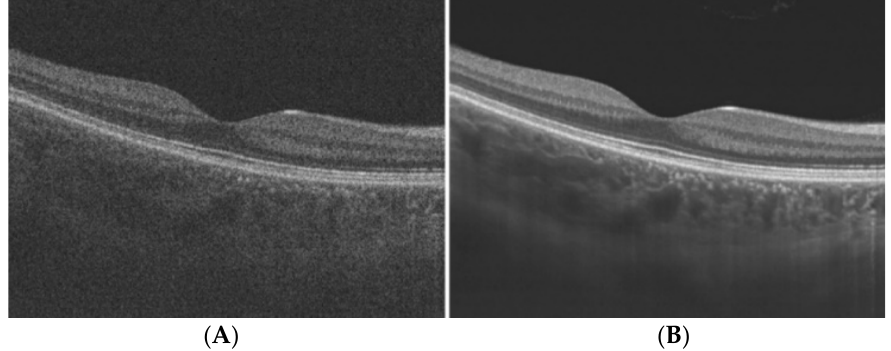
Figure 12. Speckle Noise reduction via super-resolution reconstruction: ( A ) noisy image; ( B ) denoised image.